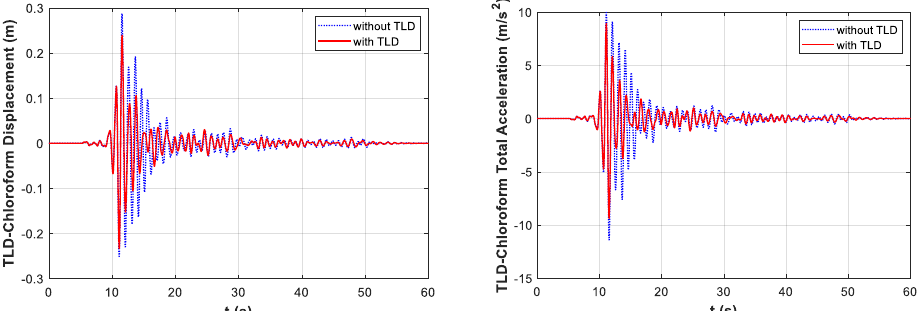
Figure 5. AHS optimization of the single-story structure displacement – time and total acceleration – time graphs in the DUZCE/BOL090 earthquake record for TLD – mercury.